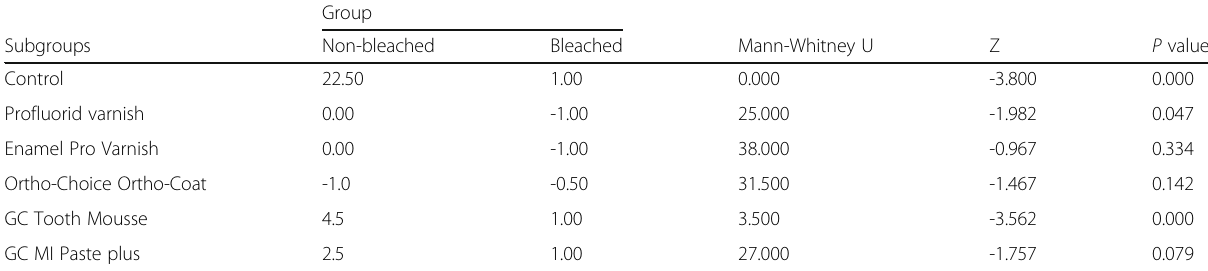
Table 4 Medians of DIAGNOdent values of demineralization changes for different bleached and non-bleached